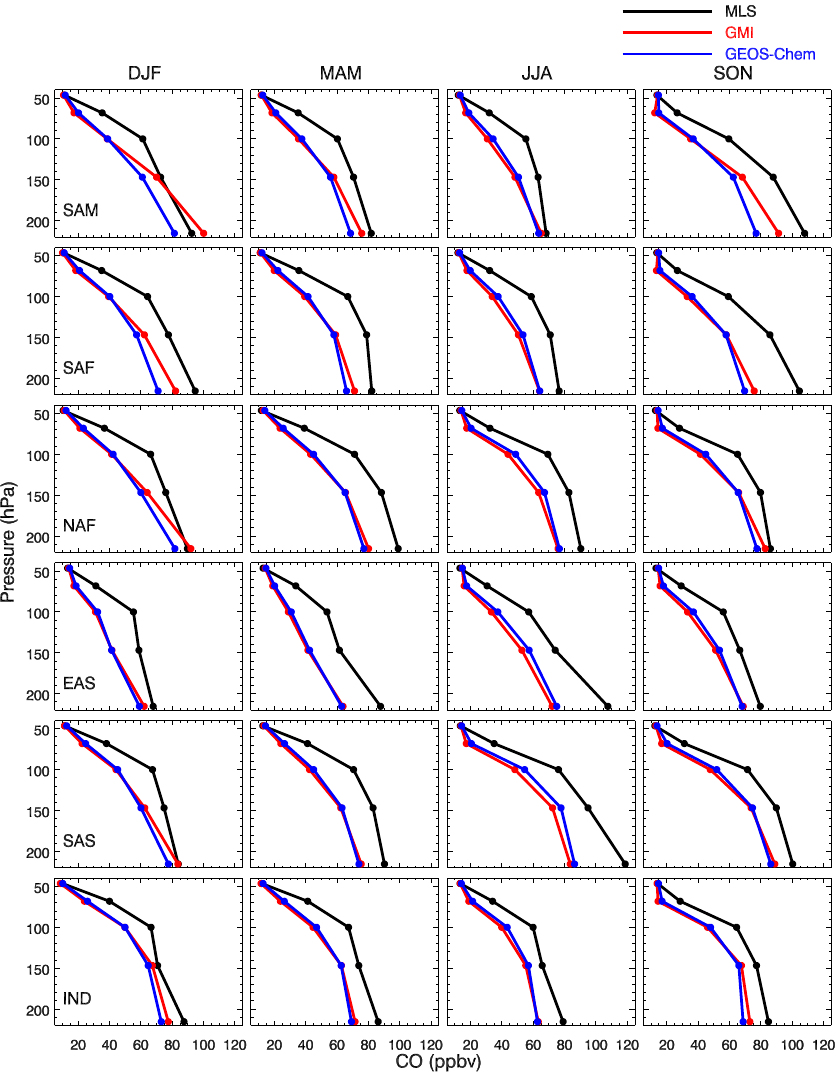
Figure 14. Climatological (8-year) seasonal mean vertical profile of CO mixing ratio from MLS V4 data (black line), GMI model simulation with MLS AKs applied (red line) and GEOS-Chem model simulation with MLS AKs applied (blue line) over the selected six regions: (top row) South America, (second row from top) southern Africa, (third row from top) northern Africa, (fourth row from top) East Asia, (fifth row from top) South Asia and (bottom row)